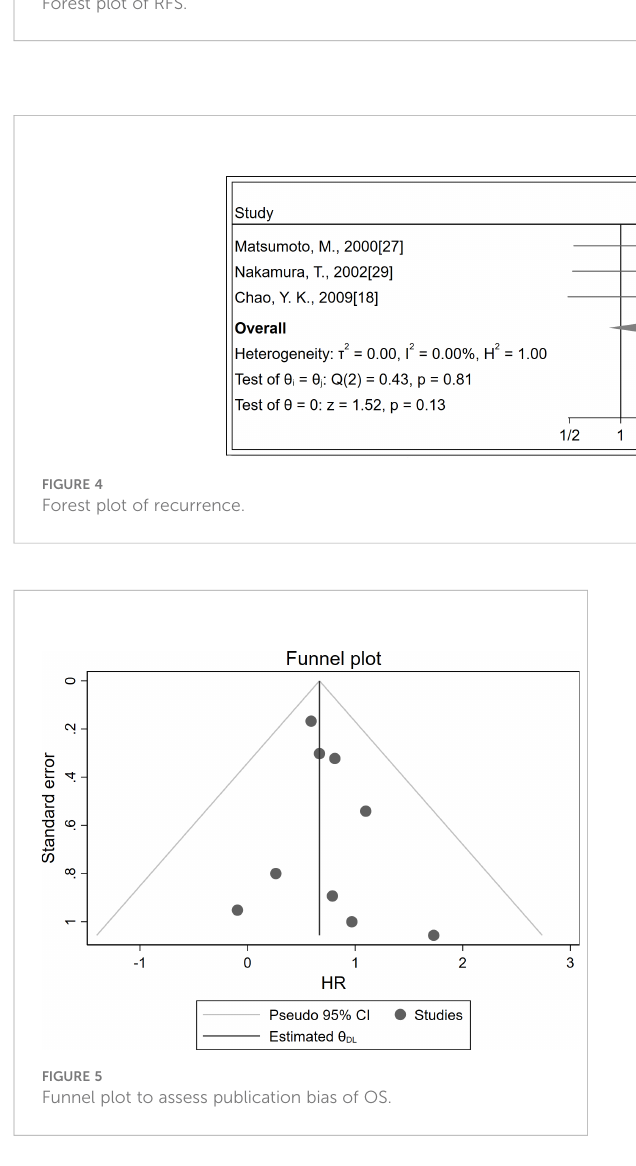
FIGURE 3 Forest plot of